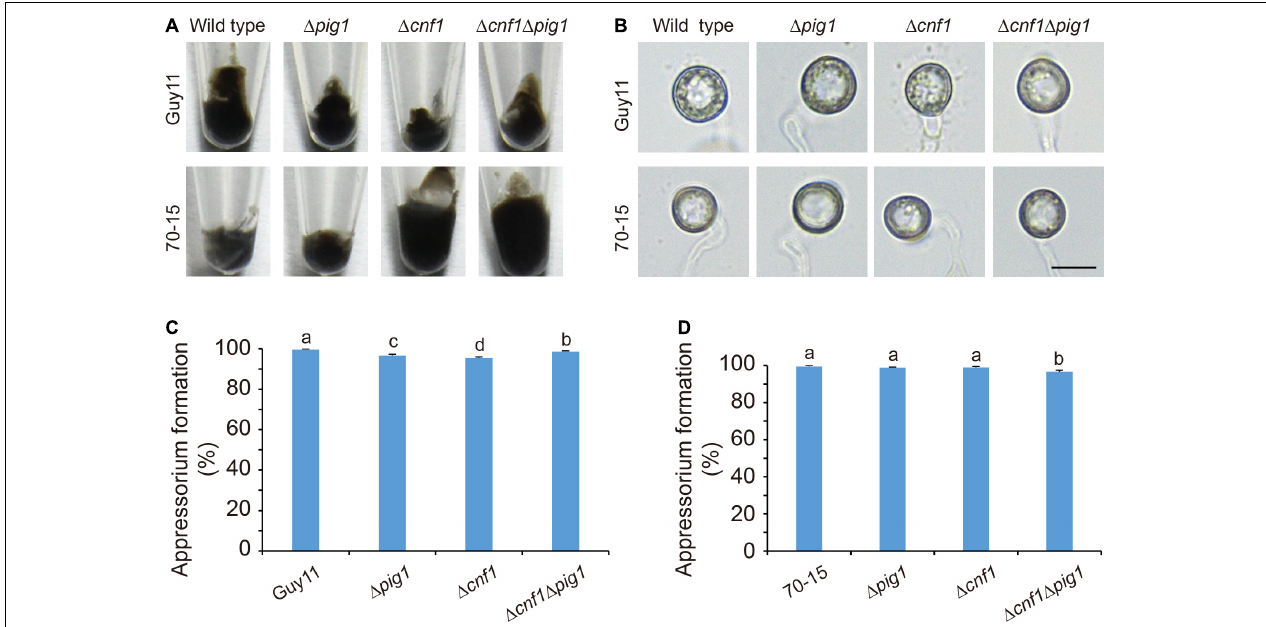
FIGURE 2 | The functions of Pig1 and Cnf1 on melanin synthesis in spores and conidia. (A) Images showing spore color. (B) Images of appressorium morphology. Bar = 10 µ m. (C,D) Appressorium formation rates in (cid:49) pig1 , (cid:49) c nf1 (cid:49) pig1 , and (cid:49) cnf1 derived from the wild-type strains Guy11 and 70-15. (C,D) Error bars represent ± SD. Different lowercase letters represent significant differences between four strains as estimated by Tukey’s HSD test ( p < 0.05).